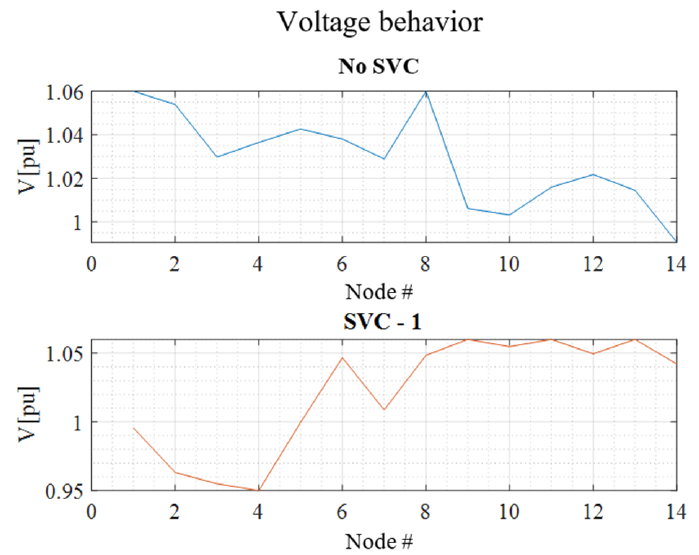
Figure 5. Voltage profile in the IEEE 14-bus test system.